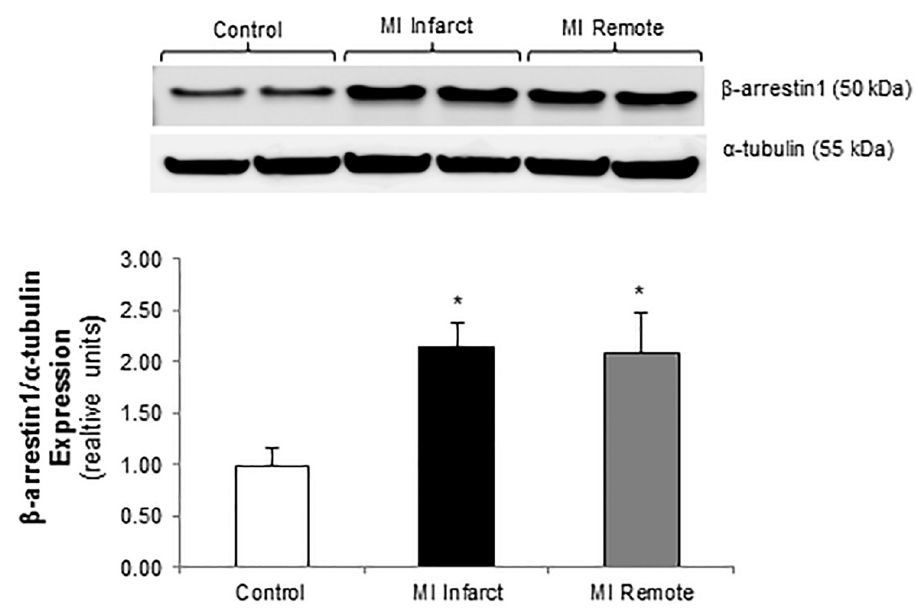
Fig 3. β -arrestin 1 expression is upregulated at 8 weeks post-myocardial infarction. Representative immunoblots ( upper panel ) showing β -arrestin1 expression in the infarct and remote territories of rat left ventricles (LV) 8 weeks post-MI vs. control LV. This membrane was stripped and re-probed with α -tubulin. α -tubulin used as loading control. Densitometric analysis shown below. � p < 0.03 vs. control; n = 4 in each group.